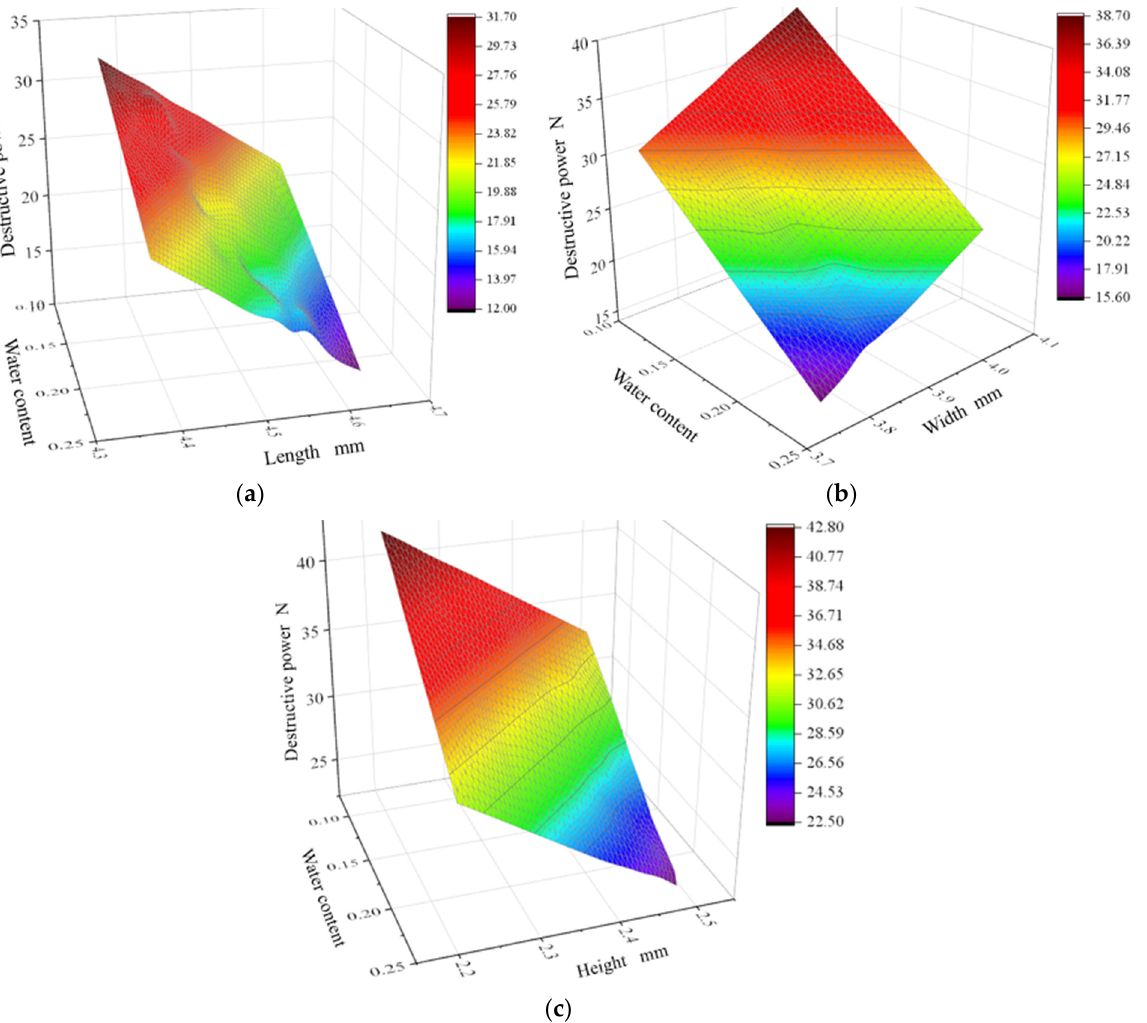
Figure 8. Surface diagram of maximum compression force in XYZ axis. ( a ) X -axis. ( b ) Y -axis. ( c ) Z